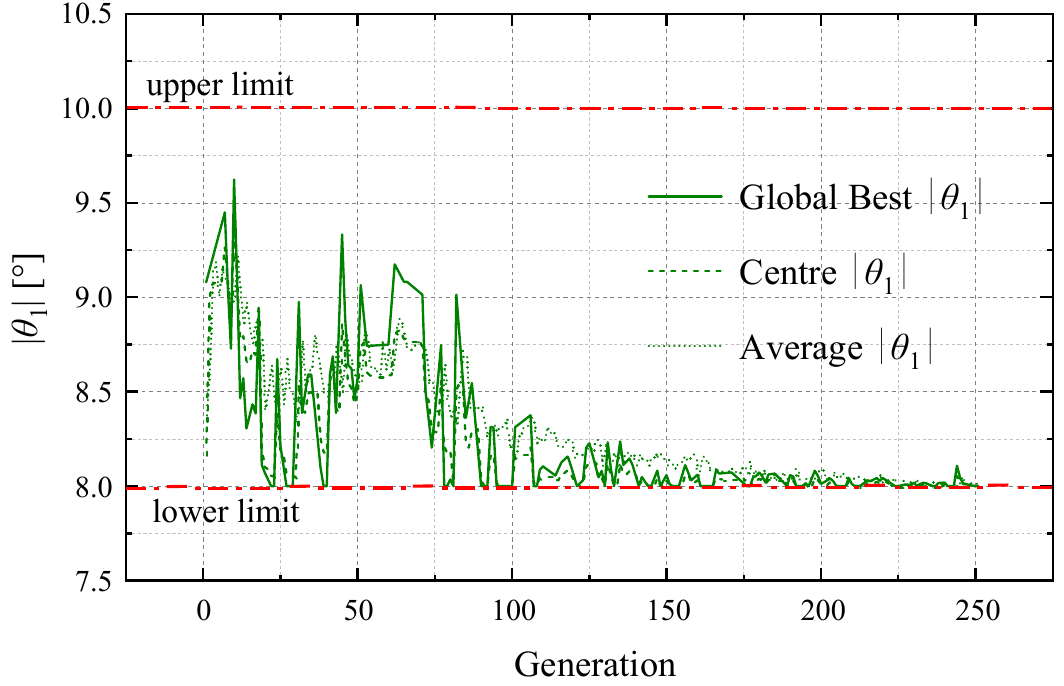
Figure 16. The convergence progress of inclination of entry straight segment: θ 1.